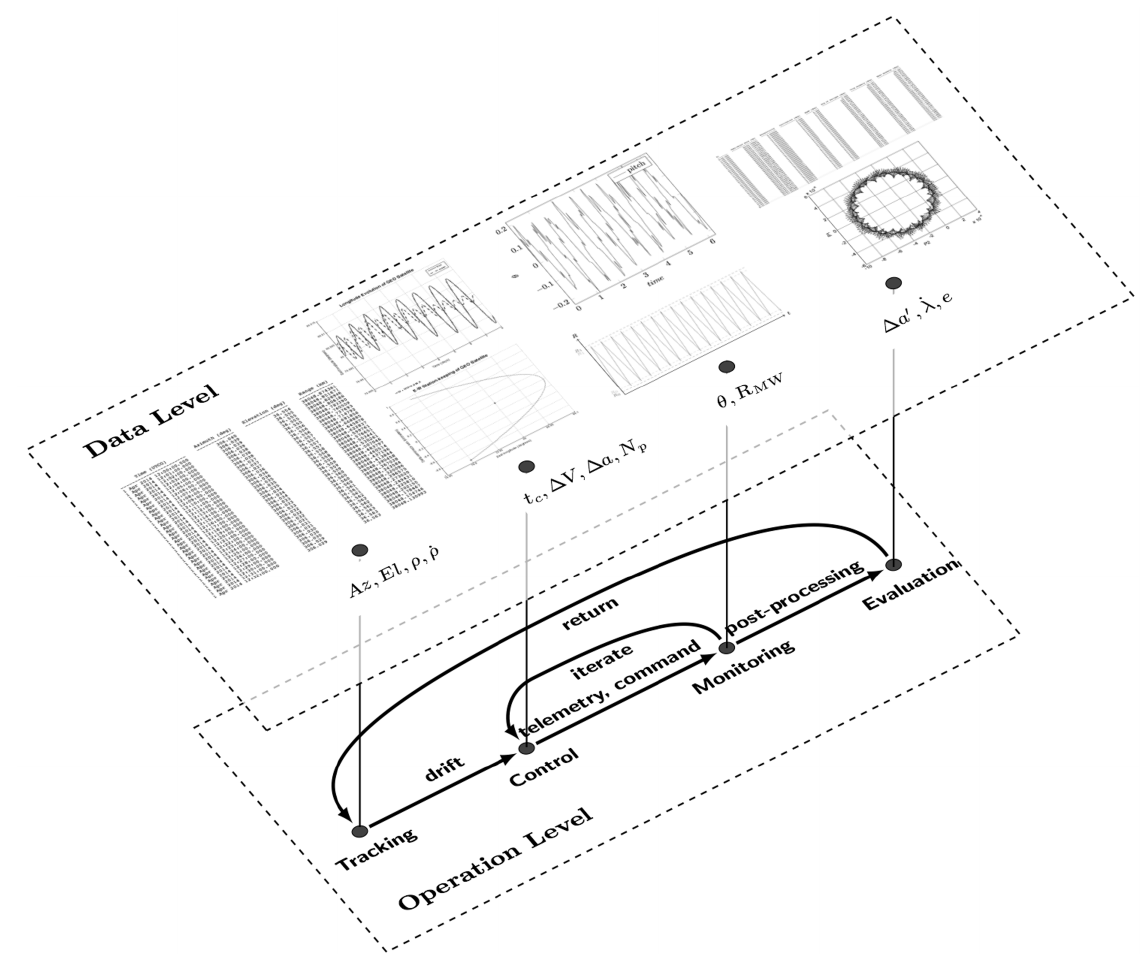
Figure 16. Illustration of the